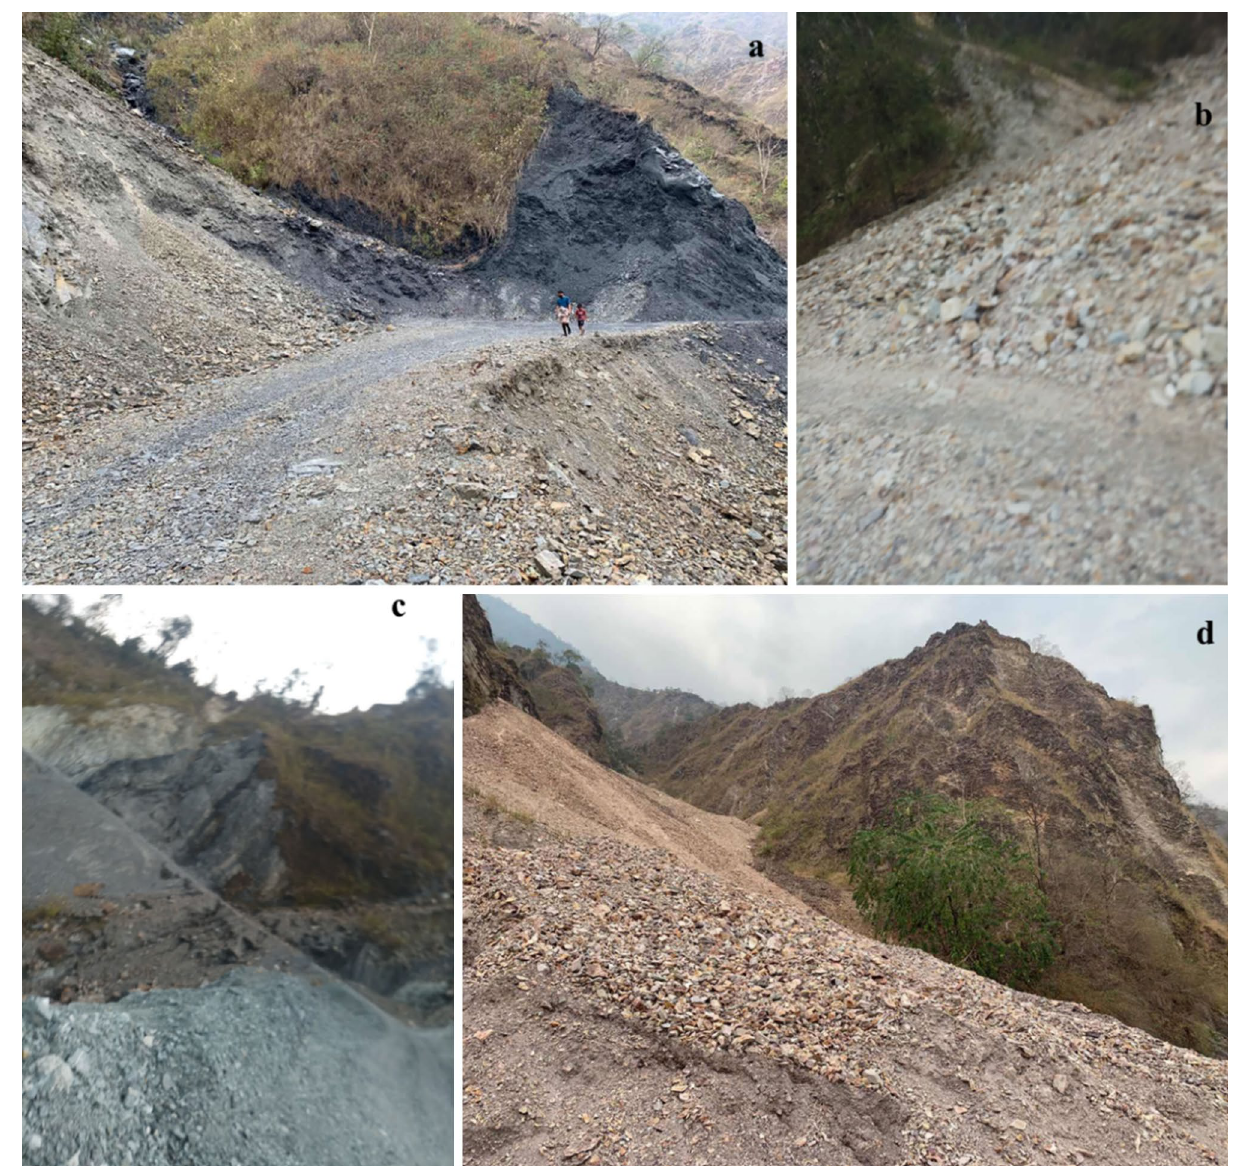
Figure 3. Some field photos of landslide events in Sharphug (latitude 26.76 N, longitude 89.7 E), under Darla Gewog (sub-division) of Chukha Dzongkhag